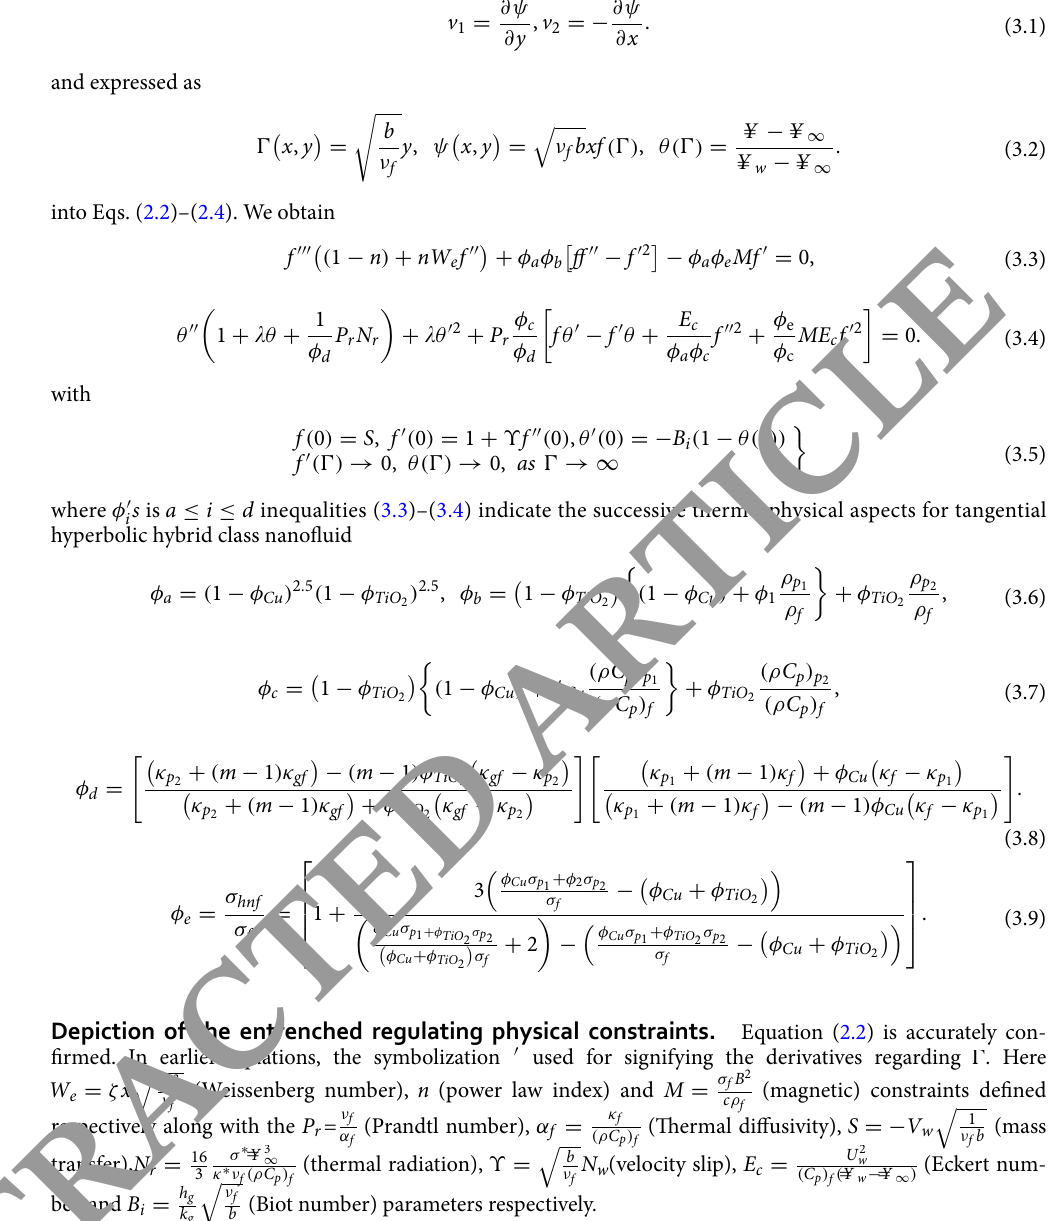
wherein τ w and q w signify the thermal flux specified by